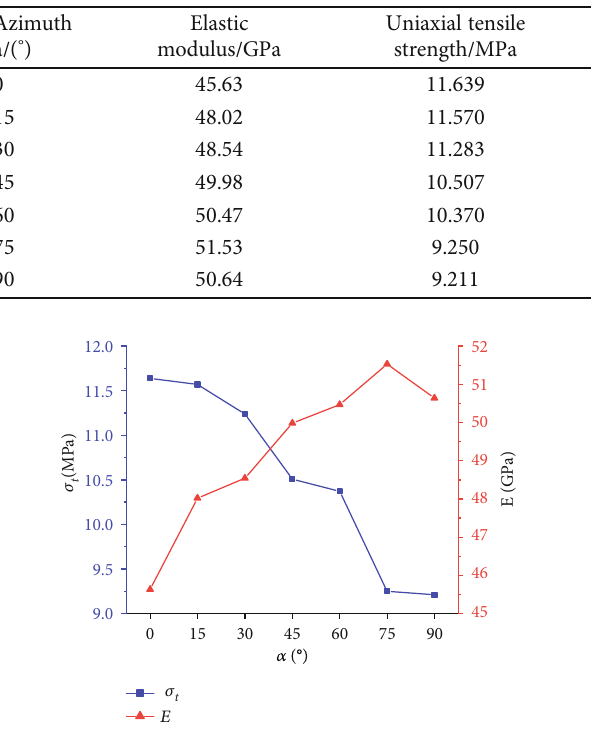
Figure 12: Trend of tensile strength and elastic modulus of shale under di ff erent azimuth